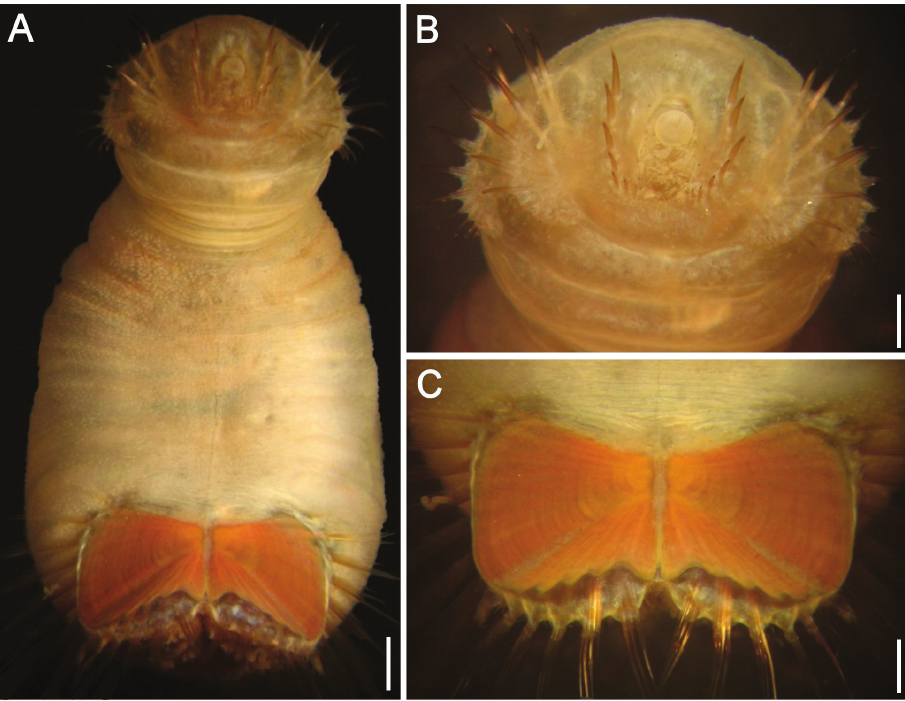
Figure 8. Sternaspis uschakovi sp. n., specimen from off Central California, U.S.A. (SIORAS 4214) A Frontal view, body ventrally bent B Anterior end, frontal view C Ventro-caudal shield, frontal view. Bars: A 1 mm B 0.5 mm C 0.6